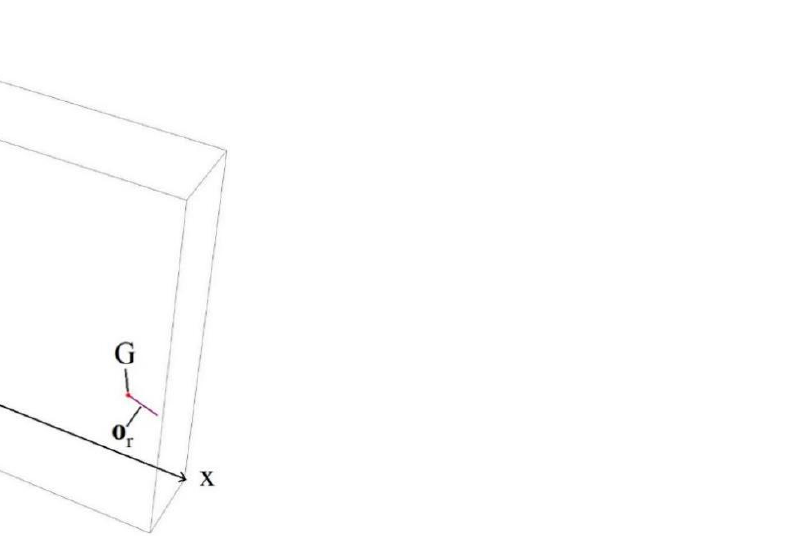
Figure 4. Three segments of full-length spine l r (the robot is in the initial position), goal point G , and orientation vector o r , defined as initial